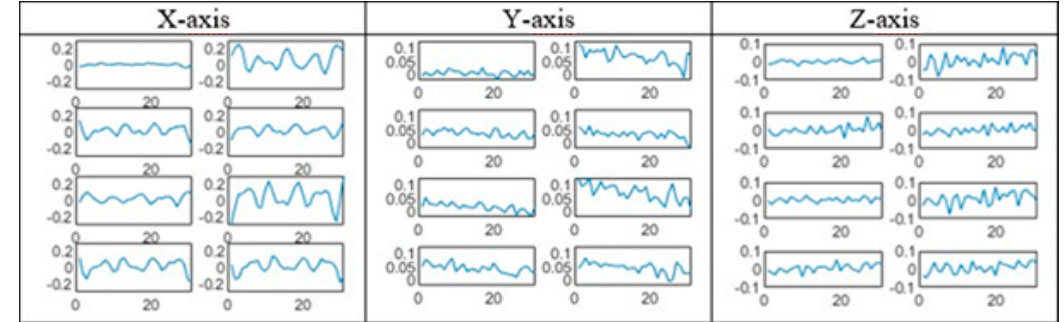
Figure 6. Kernels of first convolutional layer.